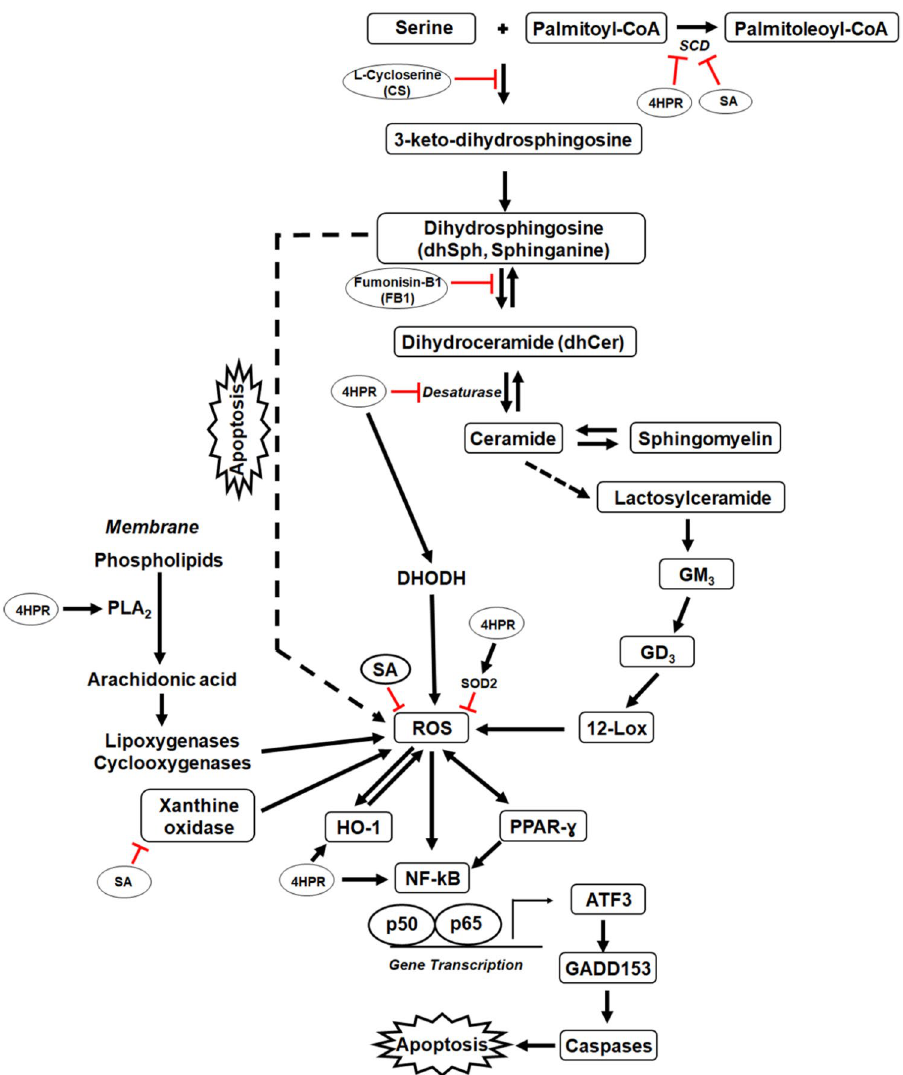
Figure 7. A schematic representation of modulation by sterculic acid of fenretinide-induced ROS generation and apoptosis in human RPE cells. As a naturally occurring inhibitor of SCD, sterculic acid (SA) inhibits the conversion of saturated fatty acids (palmitate, stearate, etc.) to mono-unsaturated fatty acid (palmitoleate, oleate, etc.) catalyzed by SCD. SA, if it only inhibits SCD, would be expected to be pro-apoptotic as SCD inhibition favors ceramide synthesis. However, we show here that pretreatment with SA: (i) inhibits xanthine oxidase- catalyzed ROS formation; (ii) suppresses fenretinide-induced ROS generation that leads to downregulation of the expression of downstream mediators (ATF3, GADD153 and HO-1) and activation of caspase-3; and (iii) mitigates caspase-mediated apoptosis in ARPE-19 cells. Arrows indicate putative direction of effect, and a blunted line represents an inhibitory effect. Dotted line represents a “potential” formation. 12-Lox 12-lipoxygenase, 4HPR Fenretinide ( N -(4-hydroxyphenyl)-retinamide, DHODH dihydroorotate dehydrogenase, GM3 and GD3 gangliosides, HO-1 heme oxygenase 1, PLA 2 phospholipase A 2 , ROS reactive oxygen species, SA sterculic acid, SCD